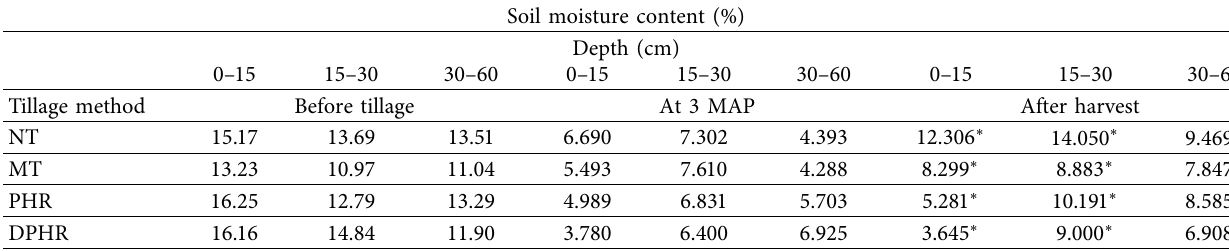
Table 4: Tillage method’s effect on soil moisture